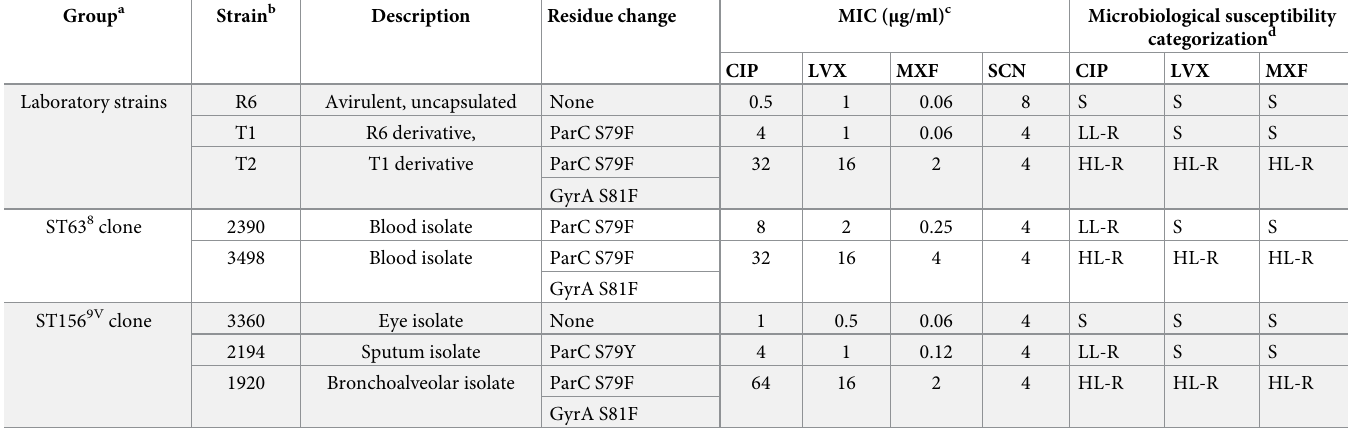
Table 1. Characteristics of S . pneumoniae